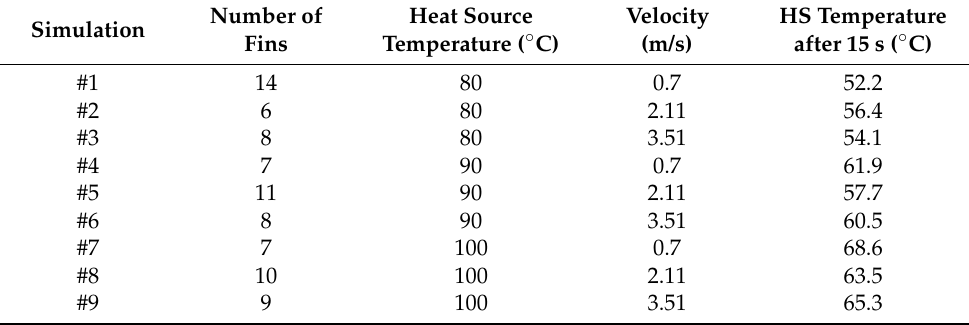
Table 4. Correlation between heat sink temperature and geometrical parameters.